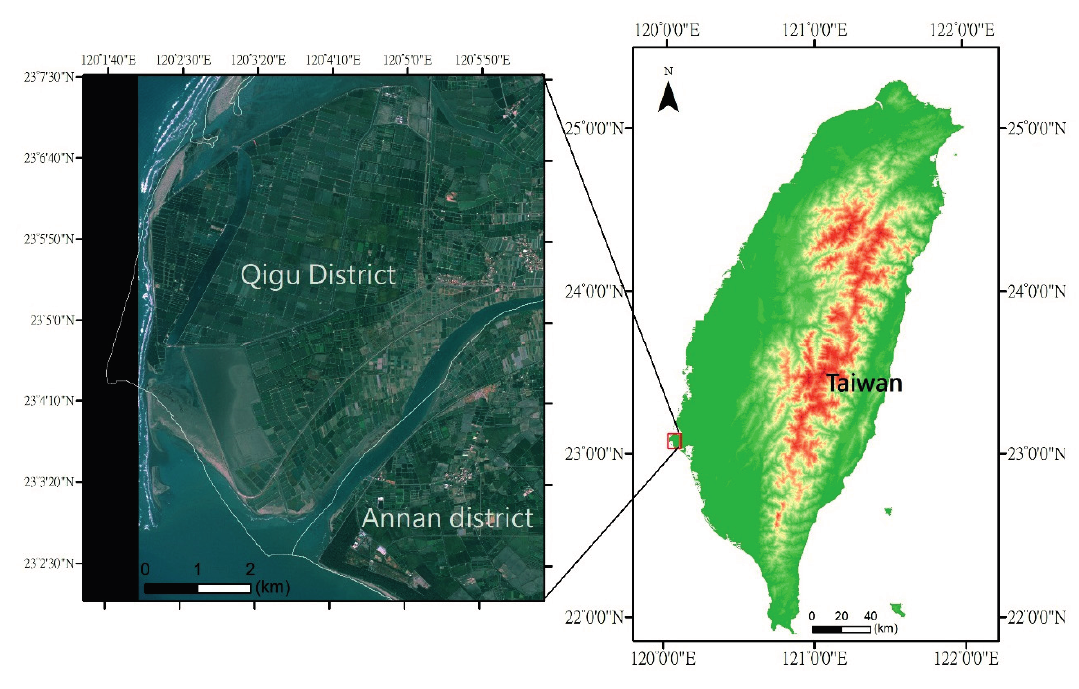
Figure 1. Location of study area in Tainan, Southern